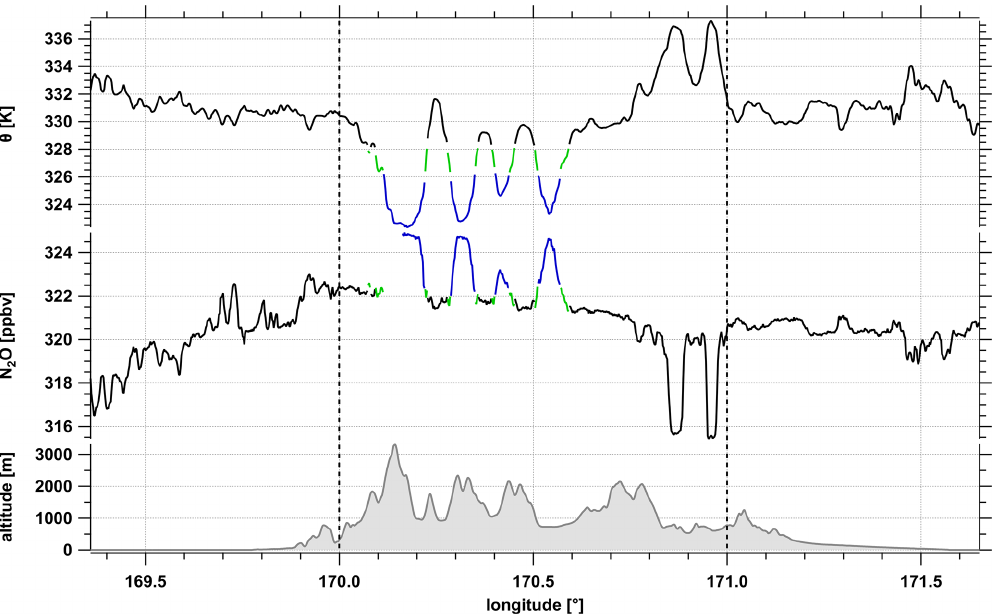
Figure 6. Time series of potential temperature (cid:50) and N 2 O for the flight leg around 18:48–19:00UTC just above the tropopause over the mountain. Colors indicate two different layers of air masses (black, blue) and a mixed layer in between (green) corresponding to Fig. 5. Vertical lines mark the upstream ( < 170 ◦ E), above mountain (170–171 ◦ E), and downstream side ( > 171 ◦